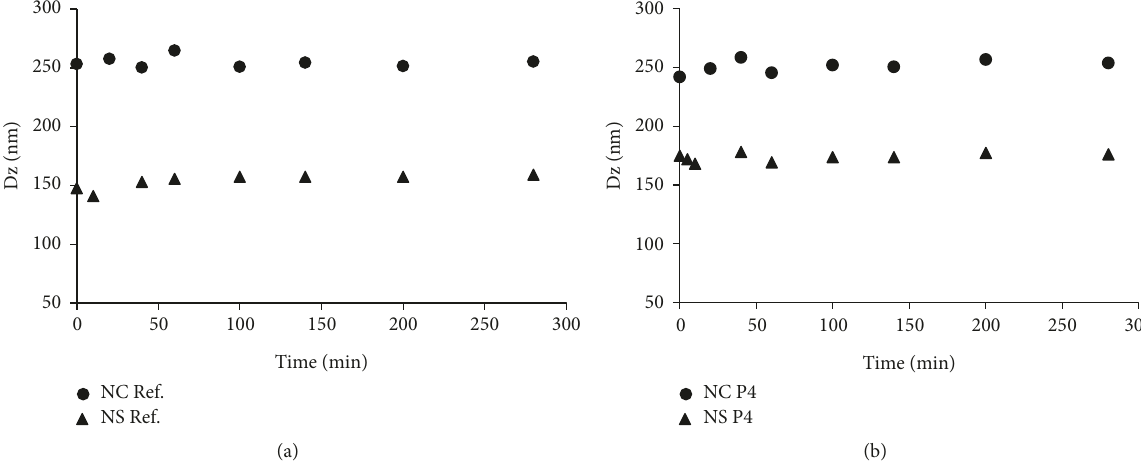
Figure 3: Average intensity diameter (Dz) of nanoparticles during miniemulsion polymerization for the formation of PMMA blank nanoparticles (Ref.) (a) and with progesterone (P4; 1 mg